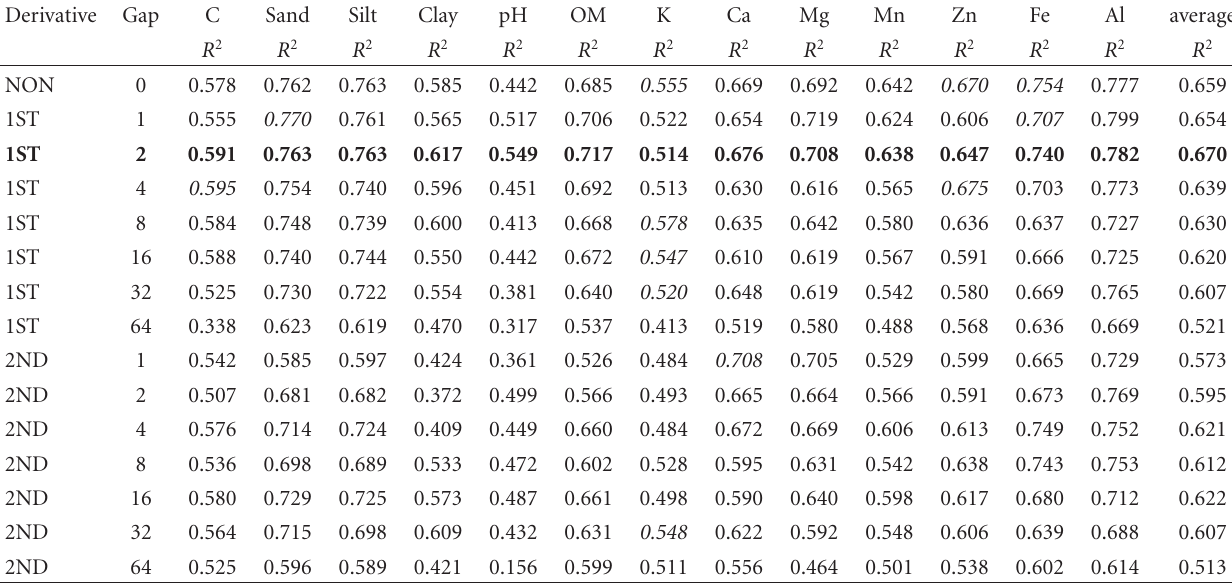
Table 2: Partial least squares (PLS) prediction model goodness of fit ( R 2 ) associated with each of 15 math treatments, for the 13 analytes that predicted with R 2 > 0 . 5, calculated using data from all 315 soil sampling locations 1 . The first derivative gap two (1Dg2, depicted in bold) was selected as the overall most successful model although it was occasionally outperformed (italic). See Section 2 for analyte